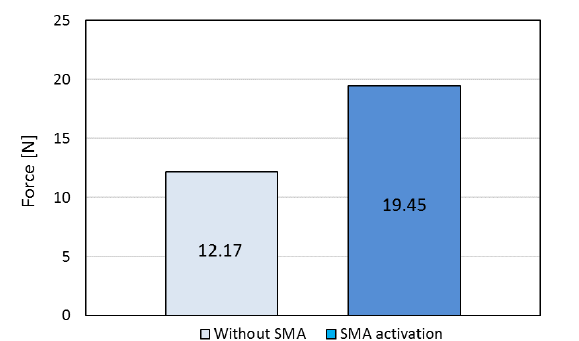
Fig. 19. Harmonics of the side forces – I h force pulsation